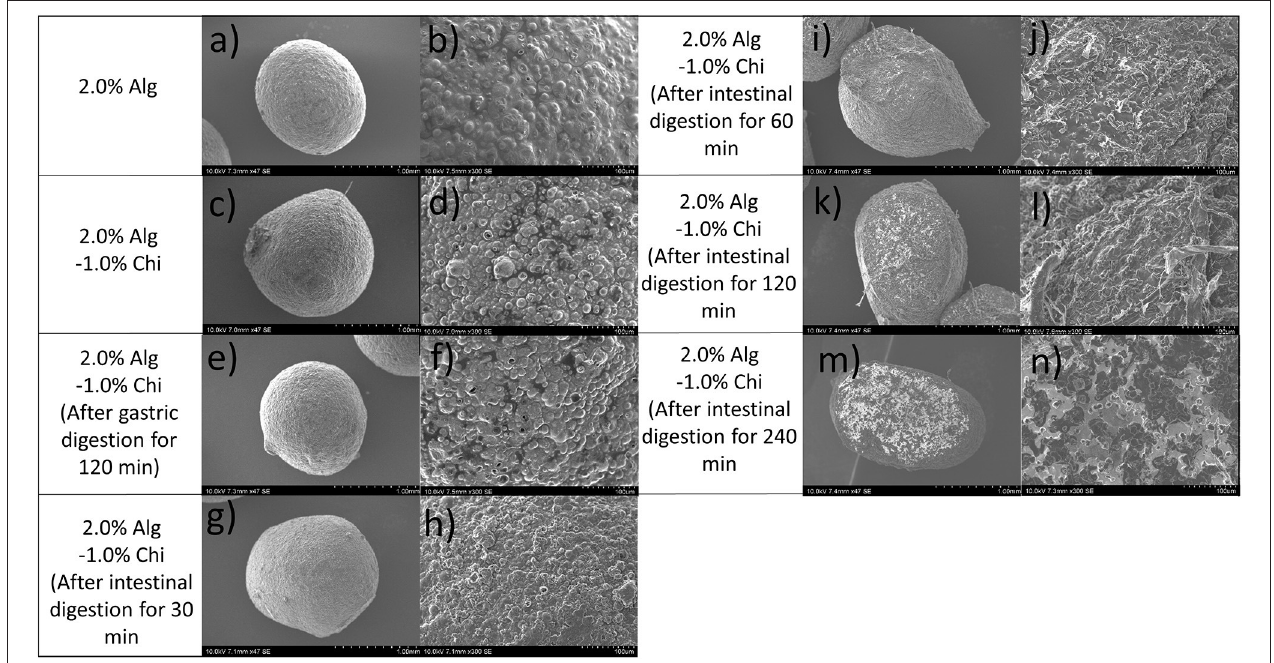
FIGURE 5 | SEM images of (a,b) 2.0% Alg hydrogel beads, (c,d) 2.0% Alg-1.0% Chi hydrogel beads, (e,f) 2.0% Alg- 1.0% Chi hydrogel beads after 120 min gastric digestion, (g–n) 2.0%- 1.0% Chi hydrogel beads after 30-240 min intestinal digestion at × 47 magnification (left) and × 300 magnification (right).